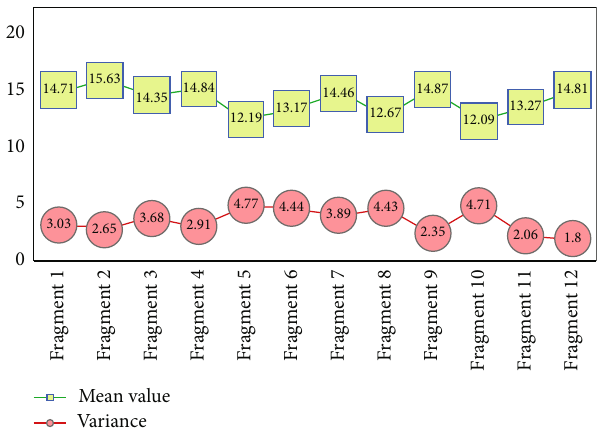
Figure 4: The recognition results of di ff erent text segments based on BP reverse neural network.